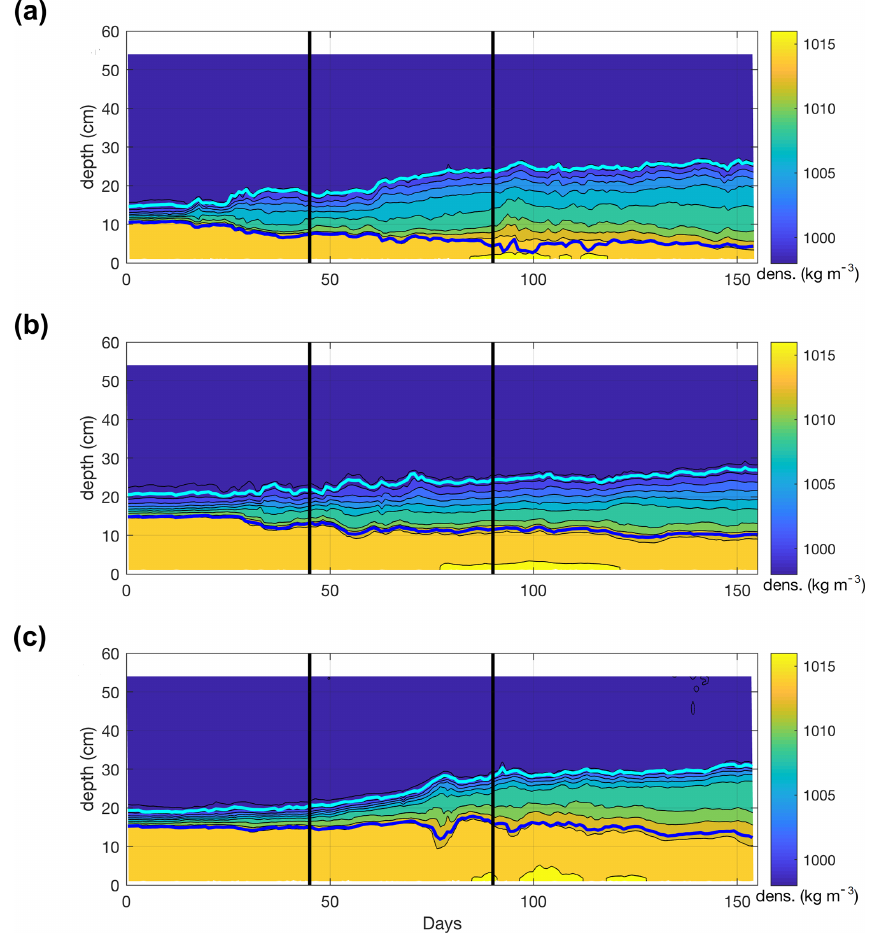
Figure 3. Temporal evolution of density and the mixed layer depth (MLD, thick cyan line) for EXP 24 (a) , EXP 26 (b) , and EXP 27 (c) . The base of the pycnocline is denoted by the thick blue line. Black solid lines indicate rotation days 45 and 90, i.e., the start and end of the high-density water injection, respectively (for reference, see Fig. 2 and Tables 1 and 2). The black isoline interval is 2kgm − 3 , starting from 1016kgm − 3 at the